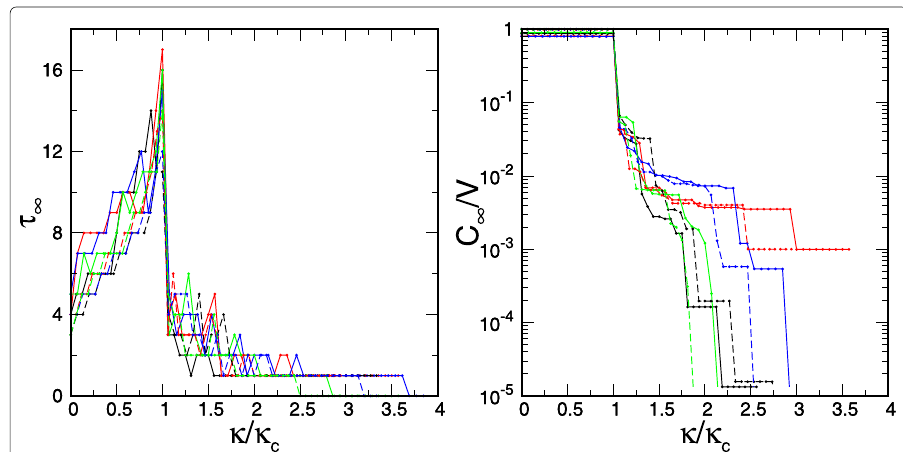
Fig. 4 (Left) Total number τ ∞ of crisis contagion stages as a function of the bankruptcy threshold κ and (right) total crisis cost C ∞ as a function of the bankruptcy threshold κ . The total cost C ∞ is defined according to the formula (7), i.e., C ∞ (κ) = C (κ , τ ∞ ) . We use the WTN for years 2004 (black), 2008 (red), 2012 (blue), and 2016 (green). Solid lines correspond to the model A: once a country goes to bankruptcy, it is prevented to import products with the exception of petroleum and gas. Dashed lines correspond to the model B: once a country goes to bankruptcy, it is prevented to import any product. The lines allow to adapt an eye between the dots which represent the numerically computed values. The total amount of the World Trade transactions is V = 9.43 × 10 12 USD in 2004, 1.68 × 10 13 USD in 2008, 1.85 × 10 13 USD in 2012, and 1.62 × 10 13 USD in 2016. The damping factor is α =